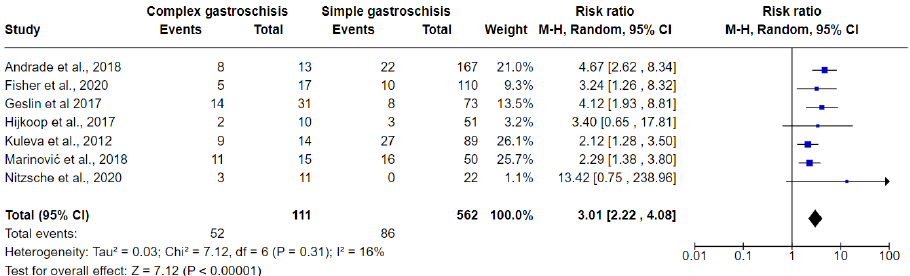
Figure 5. Forest plot of the prediction of complex gastroschisis with intraabdominal bowel dilatation (IABD), extra-abdominal bowel dilatation (EABD), and polyhydramnios.